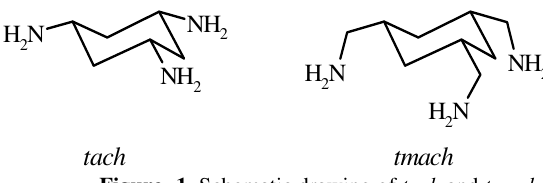
Figure- 1. Schematic drawing of tach and tmach